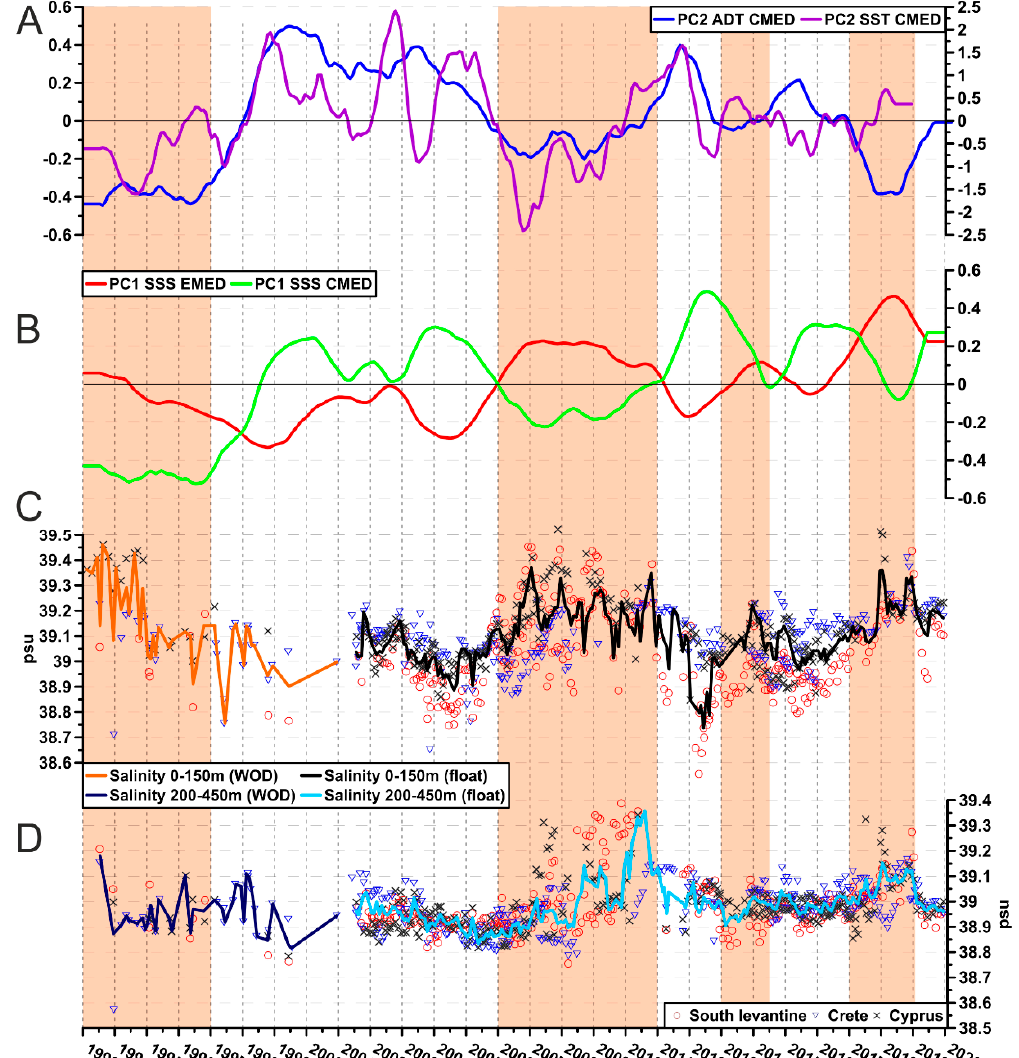
Figure 10. PC2s of the decadal variability of ADT and SST in the CMED ( A ); PC1s of the interannual variability of SSS in the CMED and EMED ( B ); monthly means of the salinity time series in the surface ( C ) and intermediate ( D ) layers of the EMED. The monthly salinity values in the three sub-sectors (South Levantine, Crete, and Cyprus) are shown by the black, blue, and red symbols; their average is represented by the solid lines. Anticyclonic periods of the NIG are emphasized in light red.